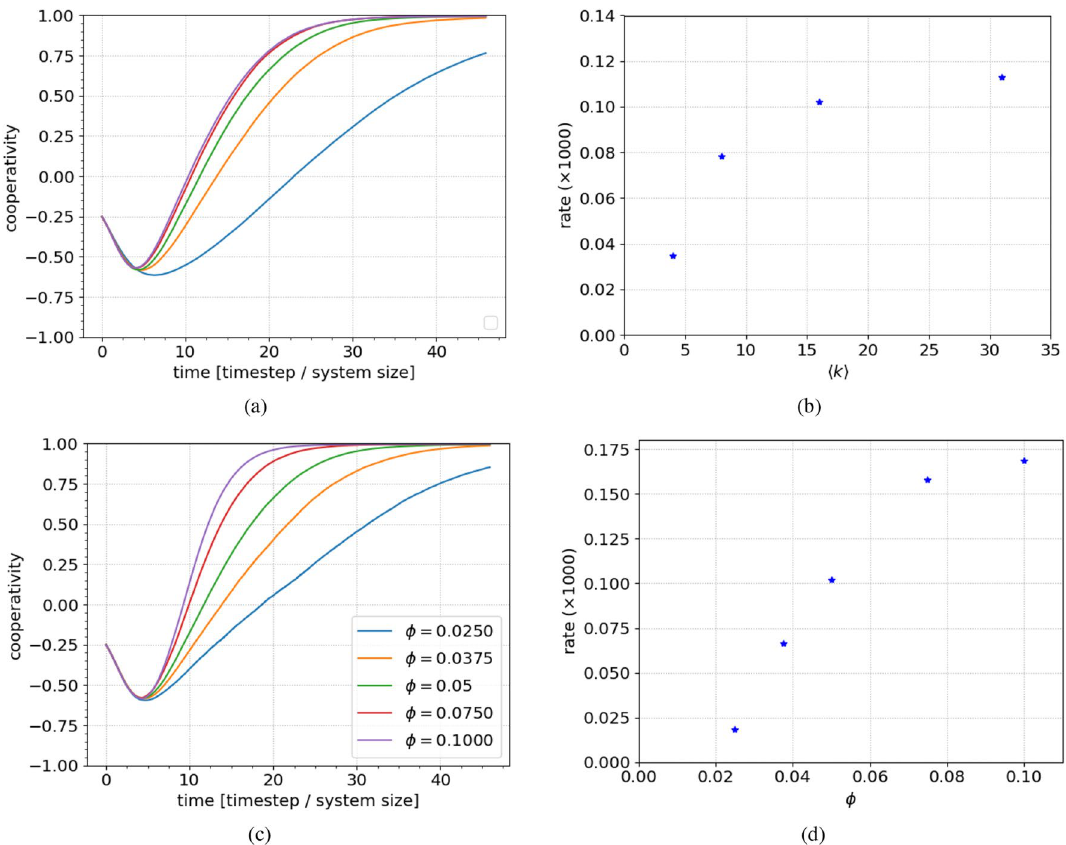
Figure 4. The effect of the connectivity and field on the convergence to the final state. ( a , b ) The average cooperativity as a function of time for different network connectivities and corresponding rates. ( c , d )